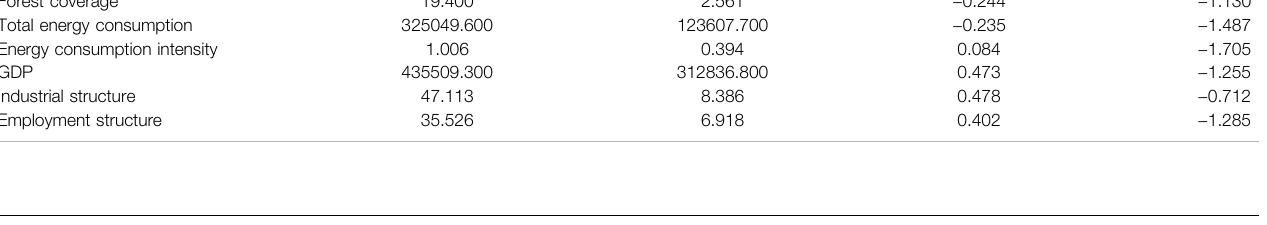
TABLE 2 | The parameter